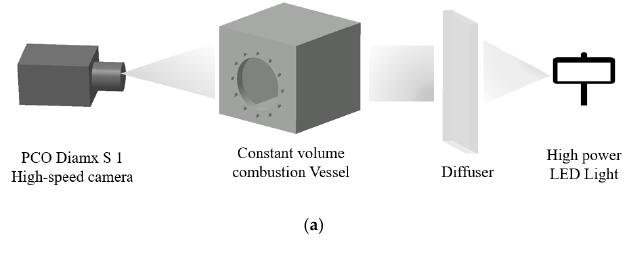
Table 2. Experiment operating settings.